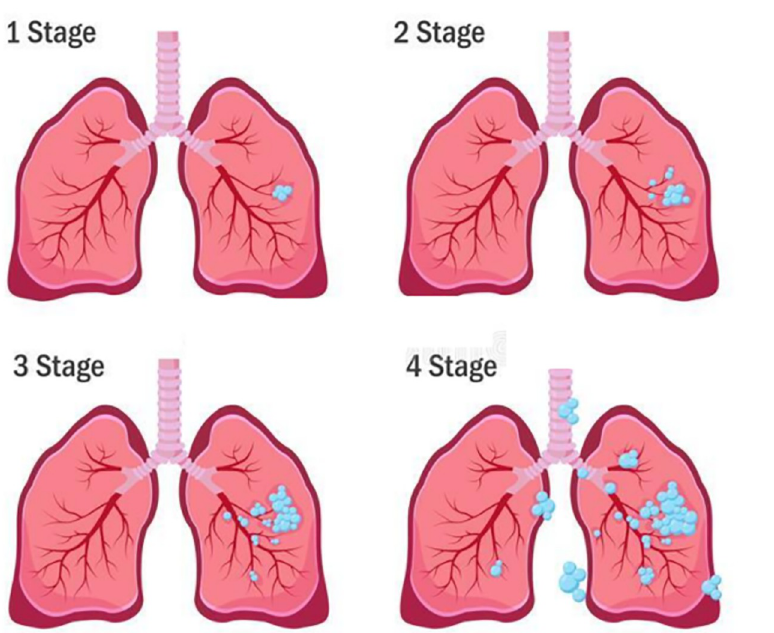
Fig 1. The four stages of lung cancer